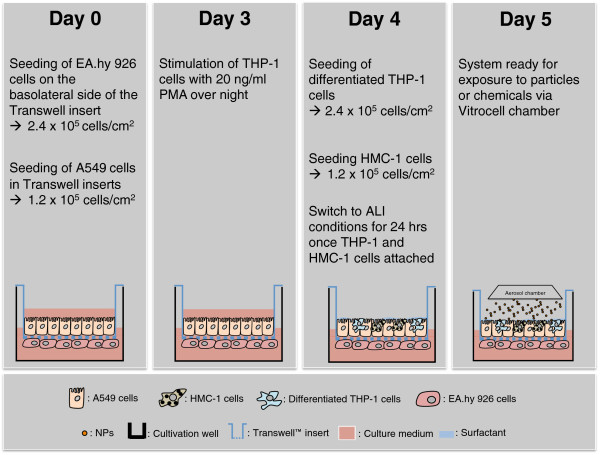
Workflow to setup an aerosol exposure experiment with the tetraculture system.